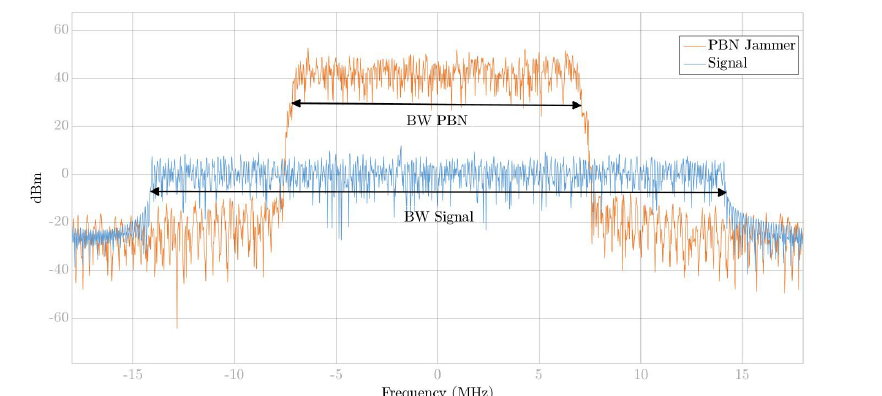
Figure 3. Demonstration of the 50% bandwidth (BW) partial band noise (PBN)